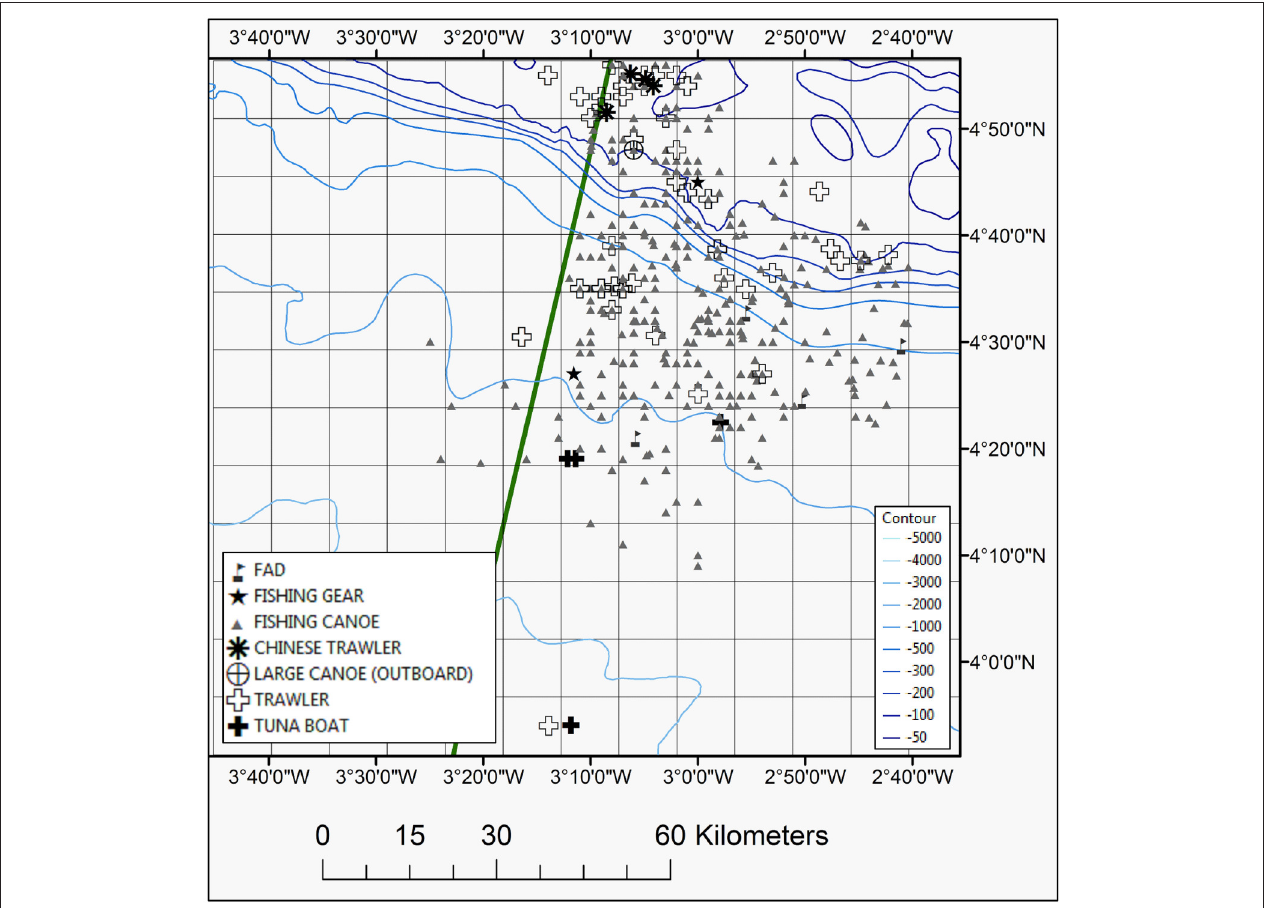
FIGURE 6 | Map showing sighting position of different fishing vessels and fishing gear plotted during the 2013 and 2014 surveys. The EEZ border between Côte d’Ivoire and Ghana is also shown (green thick line).